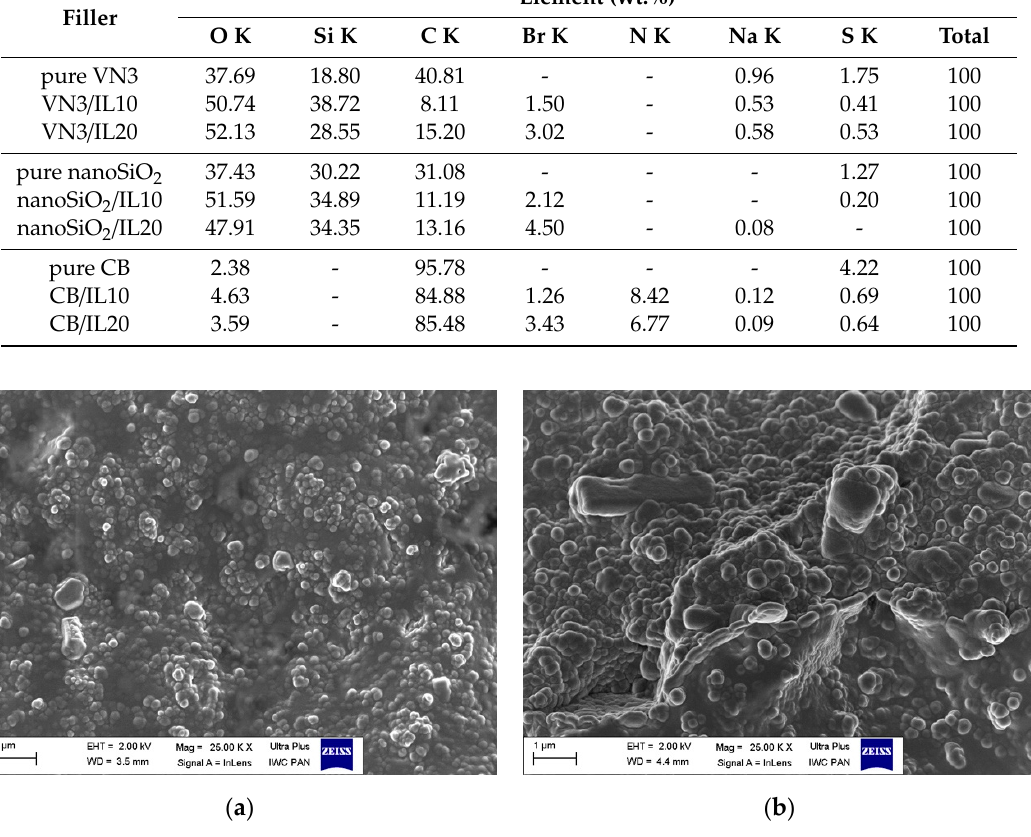
Figure 17. SEM images of vulcanizates containing: ( a ) VN3/IL20; ( b ) CB/IL20.